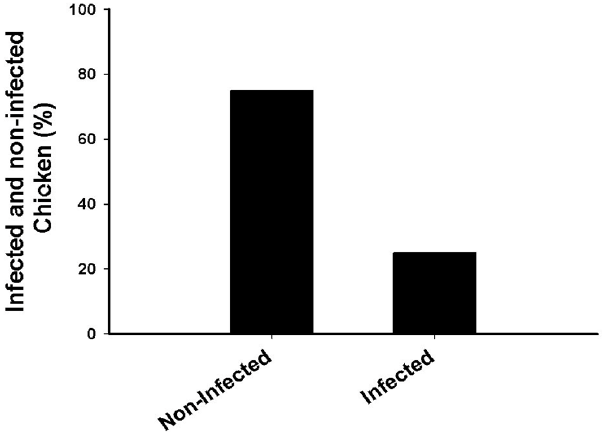
Table 1. Genus-specific and species-specific primers of Eimeria.